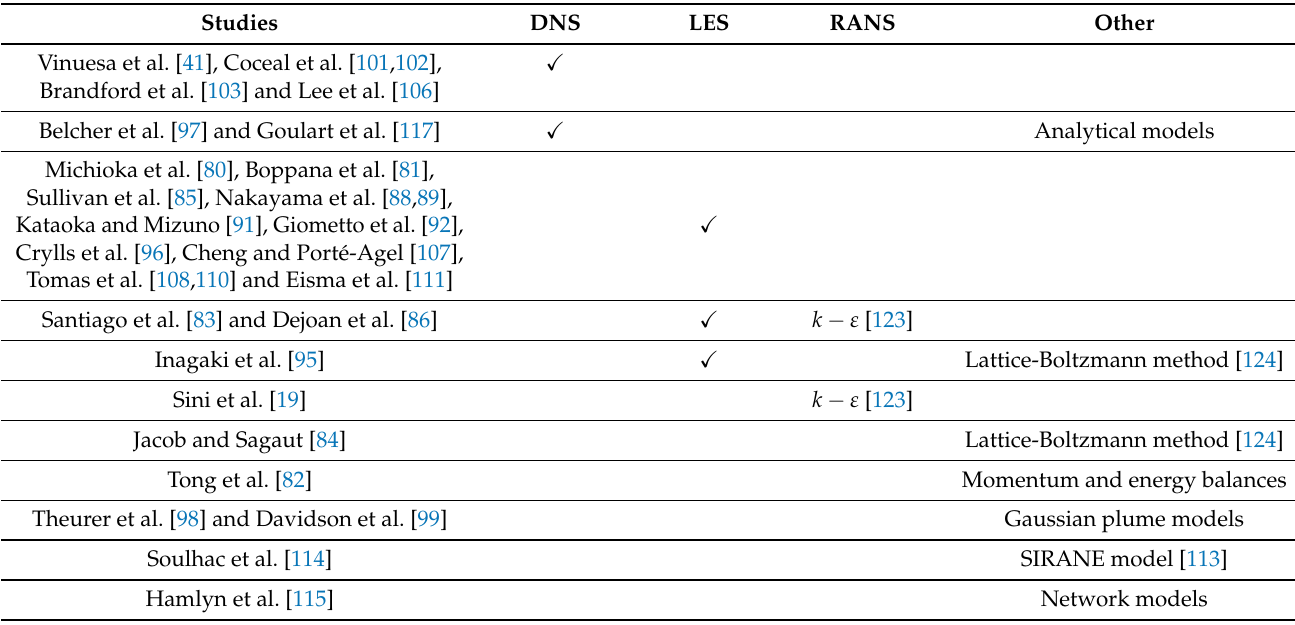
Table 1. Summary of numerical studies and simulation